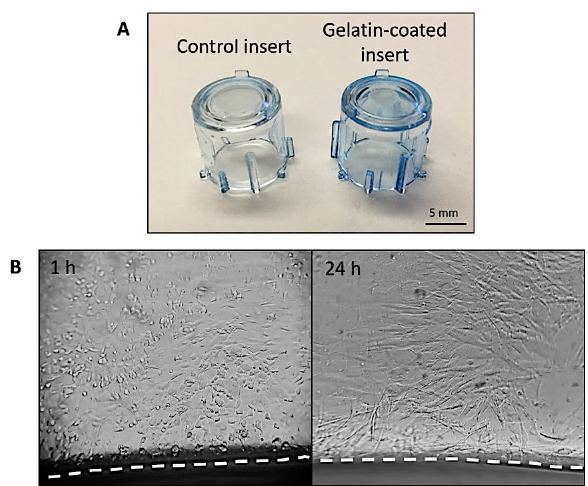
Figure 4. ( A ) Coomassie blue staining of uncoated (control) versus gelatin-coated inserts showing an increment in blue colour intensity for the latter. ( B ) Representative images of HDF on the walls of the insert 1 h and 24 h after seeding. The dashed line indicates the bottom of the insert. Images taken at 20X magnification. Note: as a result of the curvature and inclination of the insert it is only possible to correctly focus part of the field.